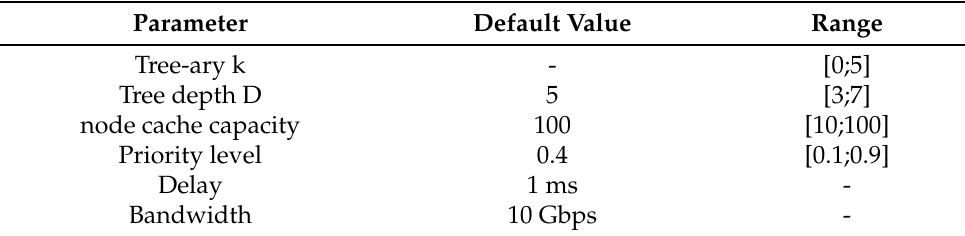
Table 2. Parameter settings for the